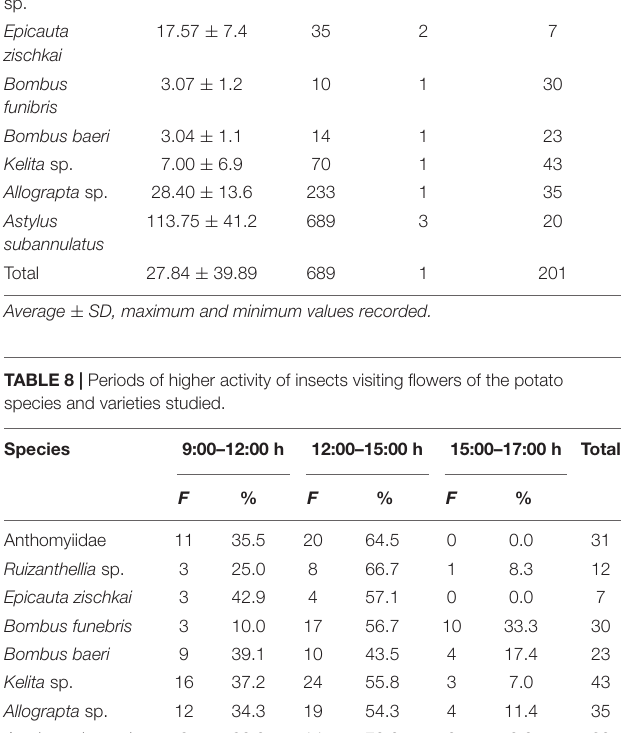
Ruizanthellia sp.